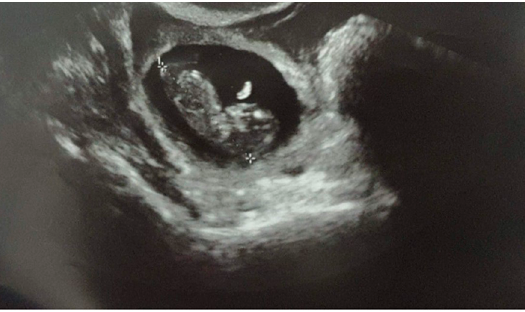
Figure 1. Ultrasound examination demonstrating a 10 + 4 weeks’ tubal pregnancy with a fetal heartbeat.